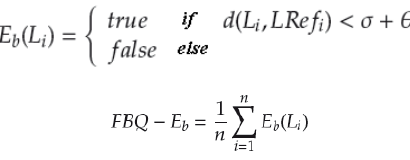
With and corresponding respectively to the corrections: instrumental, in relation to environmental conditions, with scanned scene, and multi-pixel